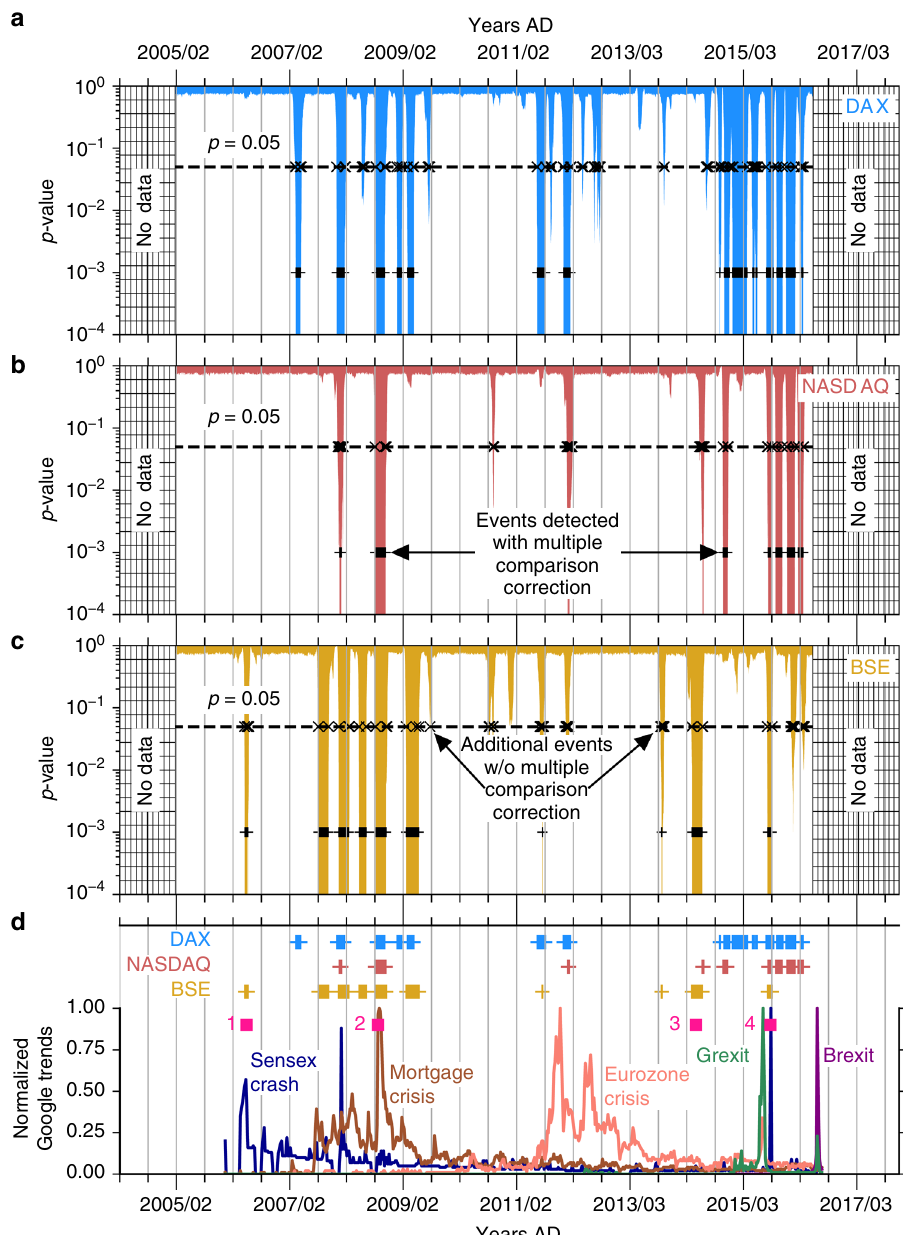
Fig. 3 Abrupt transitions in fi nancial stock indices. Applying our approach to three stock index datasets a DAX, b NASDAQ-100, and c S&P BSE SENSEX, we identify three major epochs centered around the ‘ mortgage crisis ’ , ‘ Eurozone crisis ’ , and the ‘ Grexit ’ / ‘ Brexit ’ crises, as seen from the normalized Google trends data in ( d ). In each epoch we see a high number of statistically signi fi cant dynamical shifts at α = 0.05 and these periods are interspersed with quiescent periods with far fewer of such shifts. Additional pink squares in ( d ) correspond to: (1) BSE SENSEX crash of 22 May 2006, (2) bankruptcy claim by Lehman Brothers on 15 September 2009, (3) Indian parliamentary elections from 7 April to 12 May 2014, and (4) SENSEX crash (1600 points) of 24 August 2015. The horizontal dashed lines in ( a – c ) indicate the con fi dence level α = 0.05 of the statistical test. However, when multiple comparisons are taken into account (see Methods), only a subset of p -values below 0.05 are found to be signi fi cant (shown here with plus